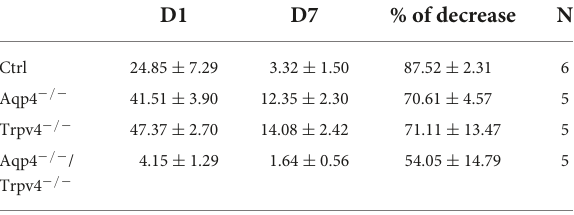
TABLE 2 Absolute values of the lesion volume (mm 3 ) determined by T 2 -weighted magnetic resonance imaging of the mouse brain 1 day (D1) and 7 days (D7) after pMCAO.